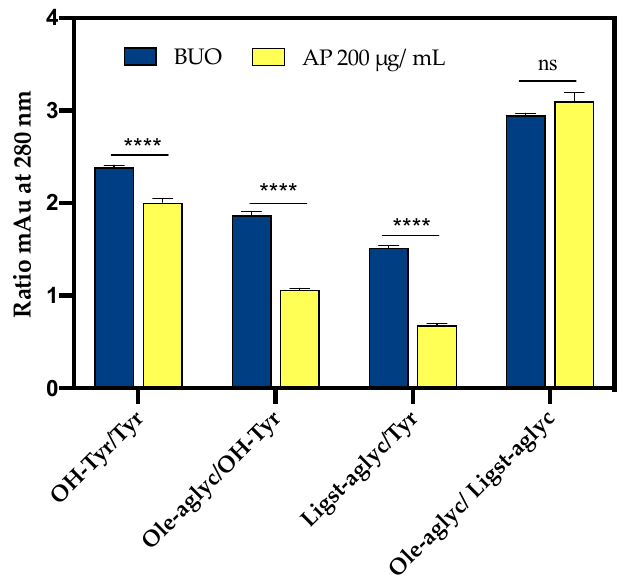
Figure 8. Specific ratios involving OH-Tyr, Tyr, Ole-aglyc, (rt 41.6 min) and ligstroside aglycone (Ligst-aglyc, rt 45.8 min), evaluated as area values at 280 nm for BUO extract and AP sample (AP 200 µg/mL) after 2 h incubation with 200 µg/mL BUO. (****, p < 0.0001). ns: not significant. Bars were analyzed by Two-Way ANOVA followed by Tukey’s test.